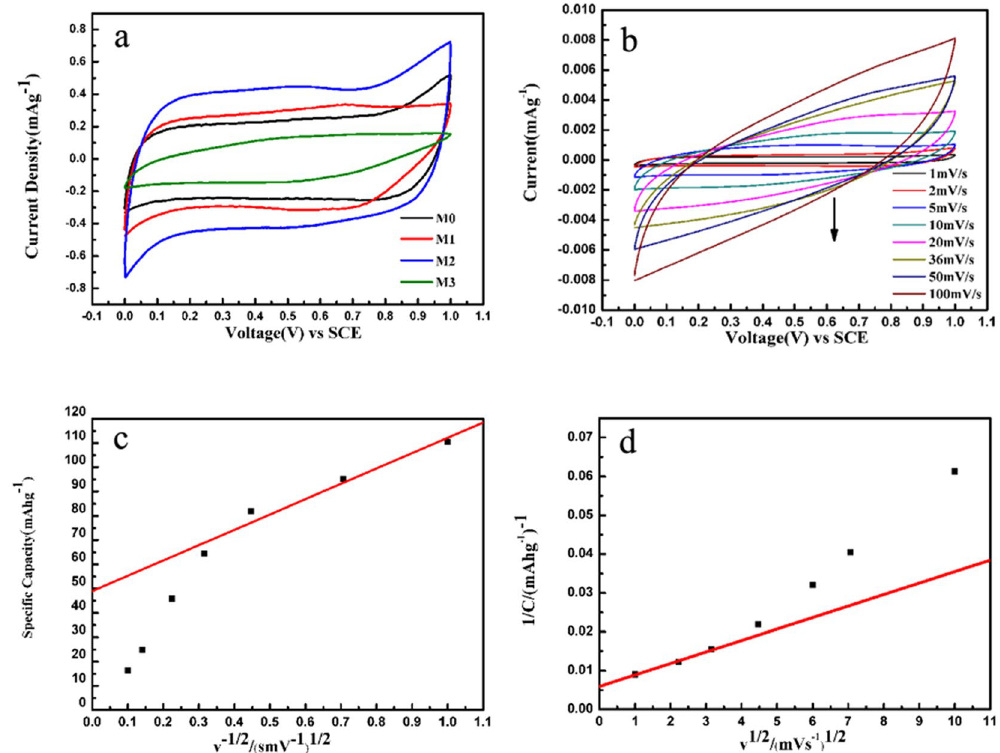
Figure 4. ( a ) CV curves of the as-prepared manganese oxide electrodes at scan rate of 1 mV s − 1 , ( b ) CV curves of M2 electrode at different scan rates, ( c ) The relationship of specific capacitance versus inverse square root of scan rate, and ( d ) The relationship of inverse specific capacity versus square root of scan